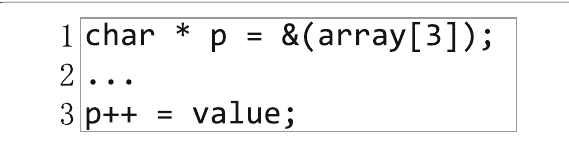
Fig. 16 The first method of initializing